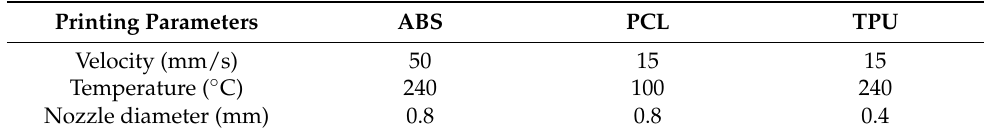
Table 1. Variable parameters for printing ABS, PCL, and